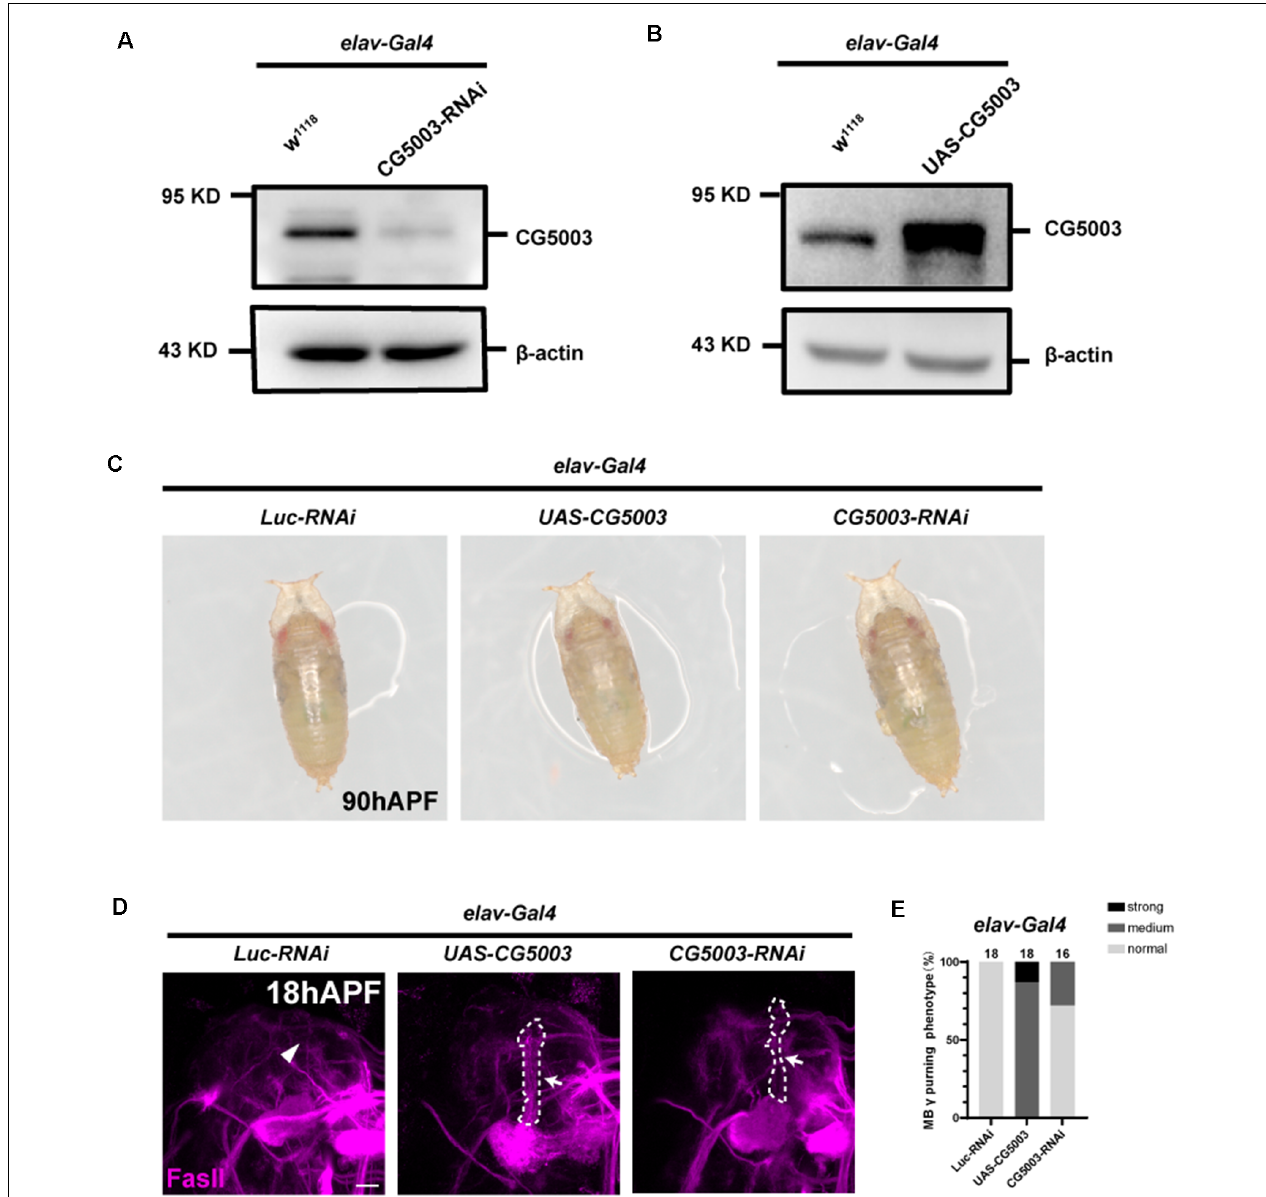
FIGURE 3 | Pan-neuronal CG5003 expression causes MB γ axon pruning defects. (A,B) Western blot analysis on the protein extracts collected from fly pupae with the indicated genotypes. Note that CG5003 protein levels increase or decrease when CG5003 or CG5003-RNAi are expressed, respectively. β -actin serves as an internal control. (C) Representative images of fly pupae with the indicated genotypes at 90 h APF. Note that red-eye elav > CG5003 or CG5003-RNAi pupae exhibit head eversion normally in a similar time scale with the control. (D,E) Representative confocal images (D) and quantifications (E) of MB γ lobe formation of control, CG5003 , and CG5003-RNAi fly pupae at 18 h APF. Note that FasII-positive γ lobes are left unpruned in MBs expressing CG5003 or CG5003-RNAi . White arrows and dashed lines encircle the area of unpruned γ lobes. White arrowheads indicate the vertical α lobes. The N number of brains dissected and quantified for